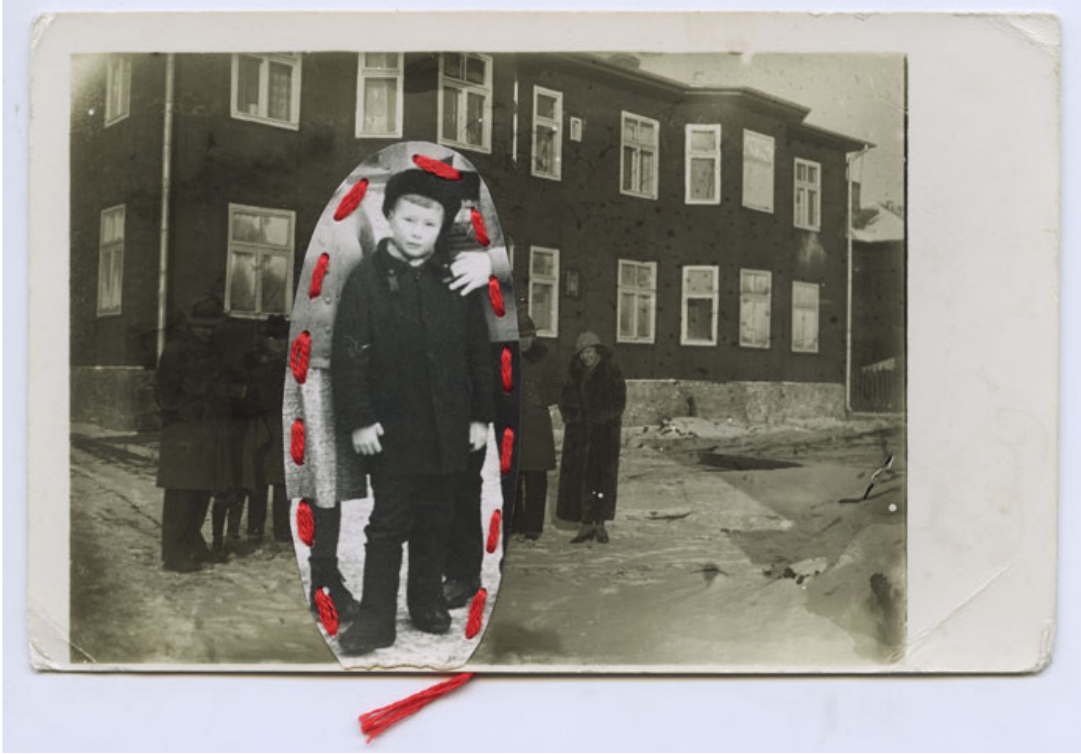
Figure 1. A boy with a